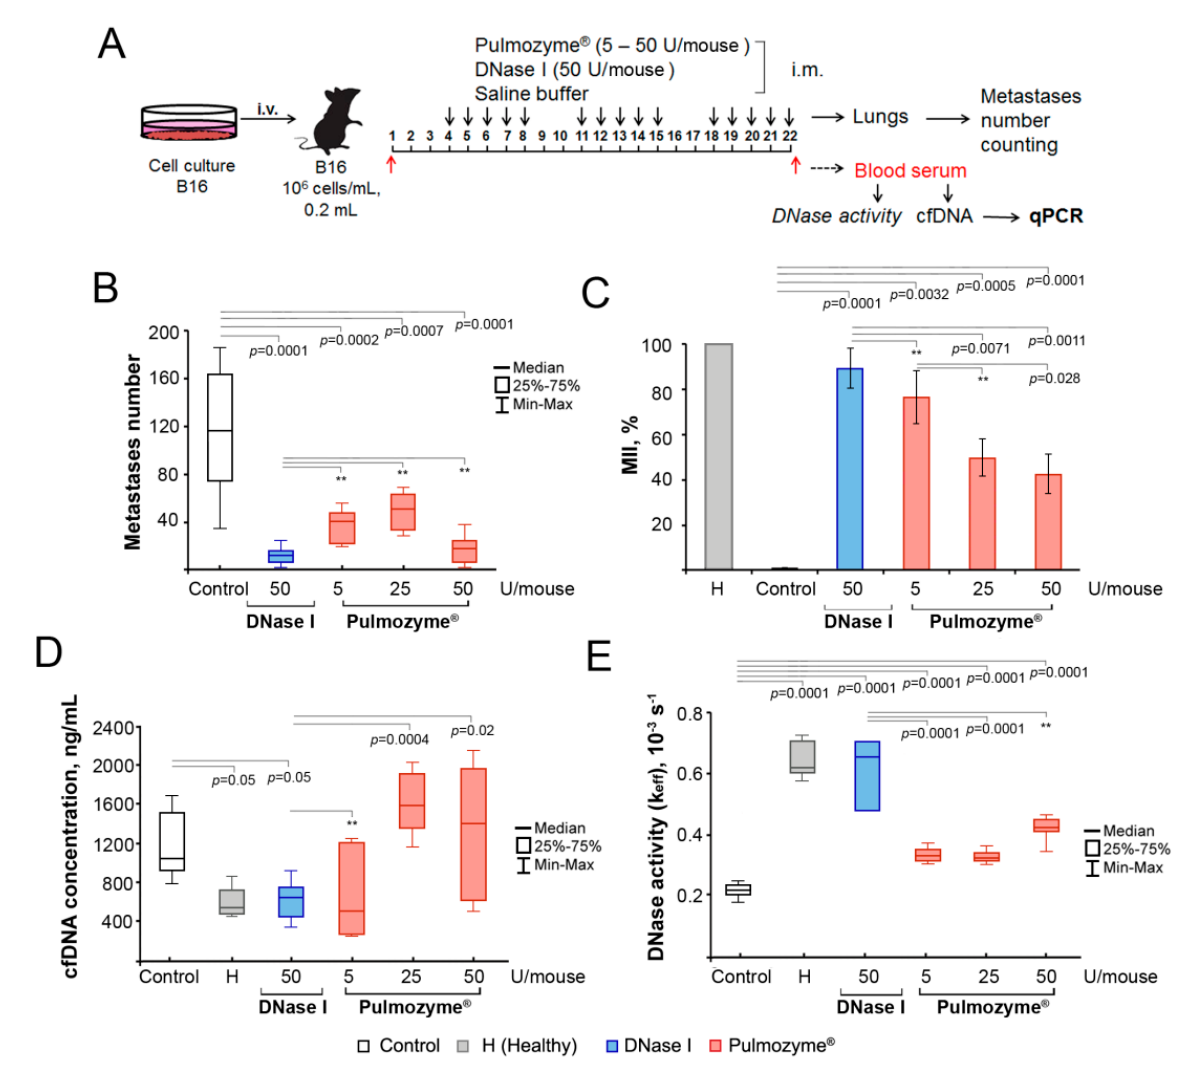
Figure 2. The effect of Pulmozyme ® and DNase I at intramuscular administration on metastases development, DNase activity and concentration of cfDNA in blood serum. ( A ) Scheme of the animal experiment. B16 cells (5 × 10 5 cells/mL, 0.2 mL) were implanted intravenously (i.v.) into C57Bl mice (male). Starting from day 4, animals received i.m. saline buffer, Pulmozyme ® (5, 25 or 50 U/mouse) or DNase I (50 U/mouse) daily, except for the weekend (5 + 2). On day 22, 1 h after the last administration, blood sampling was performed, then animals were euthanized and the lungs were collected. cfDNA was isolated from blood serum and used for subsequent qPCR analysis. ( B ) Number of surface lung metastases. ( C ) Internal metastases. MII = ([mean metastasis area control —mean metastasis area experiment ]/mean metastasis area control ) × 100%. Data are presented as mean ± SE. ( D , F ) Concentration of cfDNA ( D ) and DNase activity ( E ) of blood serum. Data are presented as median. Data were statistically analyzed using one-way ANOVA with a post hoc Tukey test. Statistical significance p < 0.05. **—statistically insignificant difference. Control group—columns/boxes outlined in black, H (healthy)—colored in grey, DNase I—blue, Pulmozyme ® —red.